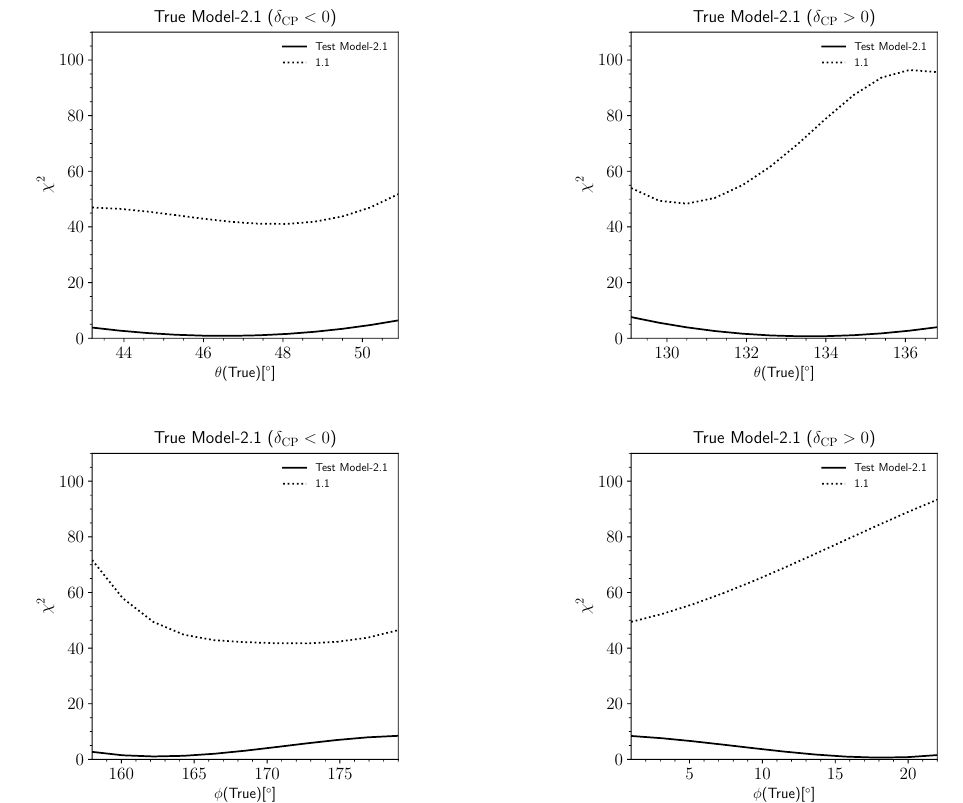
Figure 10 . Comparison between the best two-parameter model (Model 2.1) and the best one- parameter model (Model 1.1) for ESSnuSB using priors. The upper (lower) panels show the quantity (cid:31) 2 , given Model 2.1 as the true model, as function of the model parameter (cid:18) ( (cid:30) ) in its 3 (cid:27) interval min (cid:18) 3 (cid:27) ( (cid:30) 3 (cid:27) ) presented in table 8. In the panels, (cid:31) 2 for Model 2.1 is displayed with black solid curves min (when acting as a test model), whereas it is marked for Model 1.1 (i.e., the test model) by black dotted